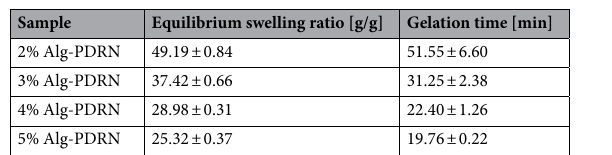
Table 1. Equilibrium swelling ratio and gelation time of Alg-PDRN as a function of Alg concentration.